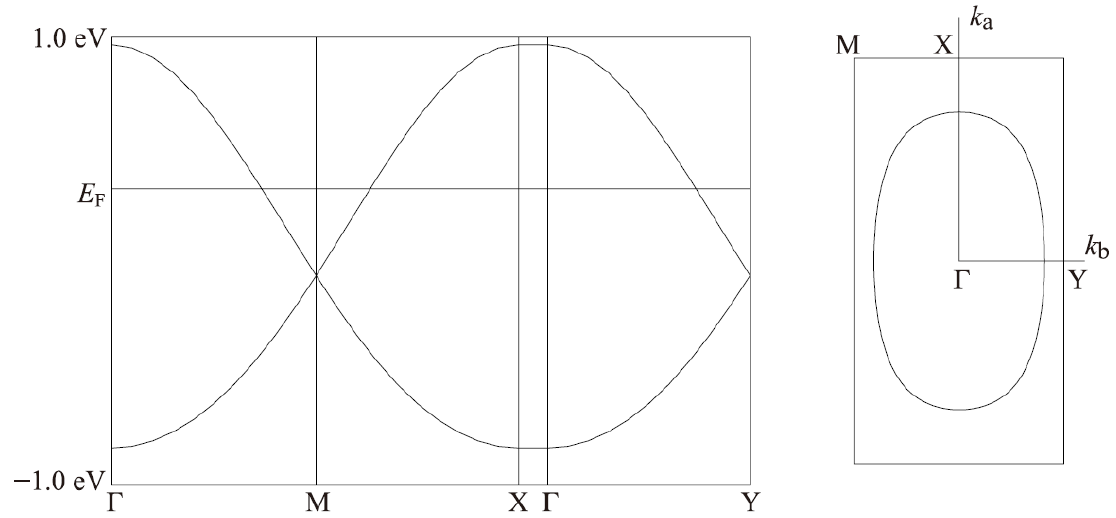
Figure 8. Band dispersions ( left ) and Fermi surfaces ( right ) of 3 at 150